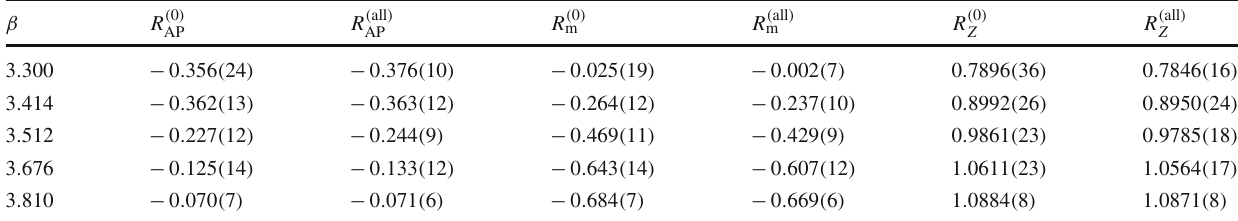
Table 3 Chirally extrapolated LCP-1 results, both for the vanishing topological charge sector, R ( 0 ) Only the former are plotted in Fig.